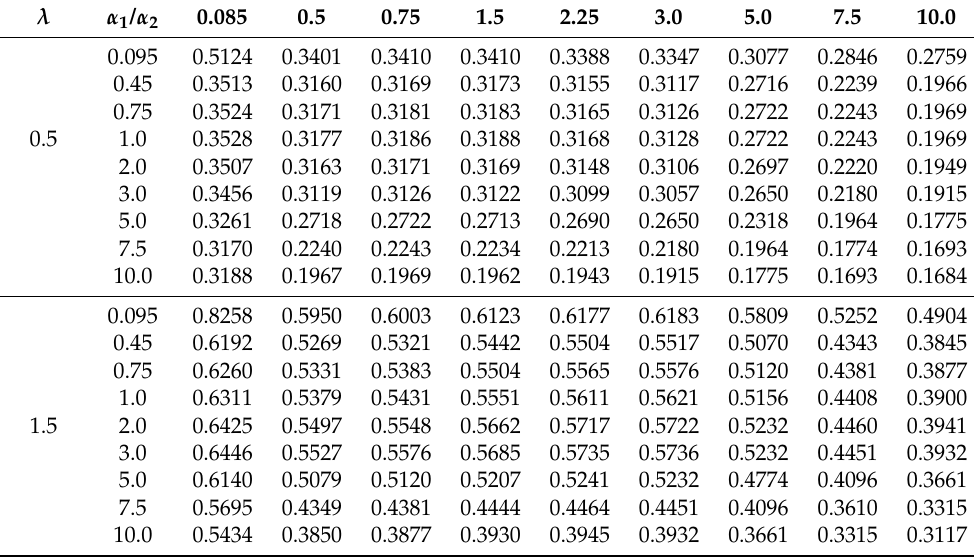
Table 1. Correlation coefficient for BVUSHN